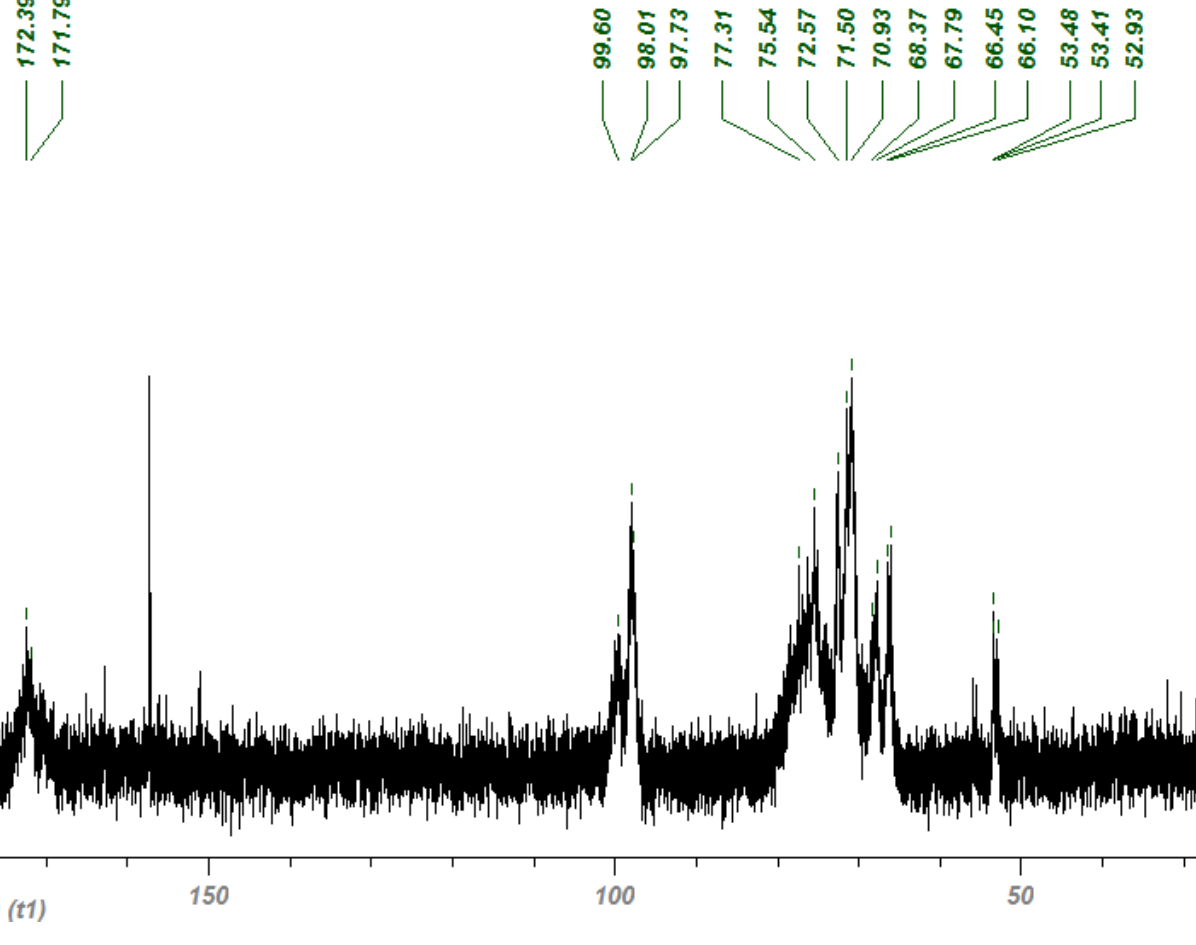
Figure 3. 13 C ‐ NMR of 2a . Figure 3. 13 C-NMR of 2a